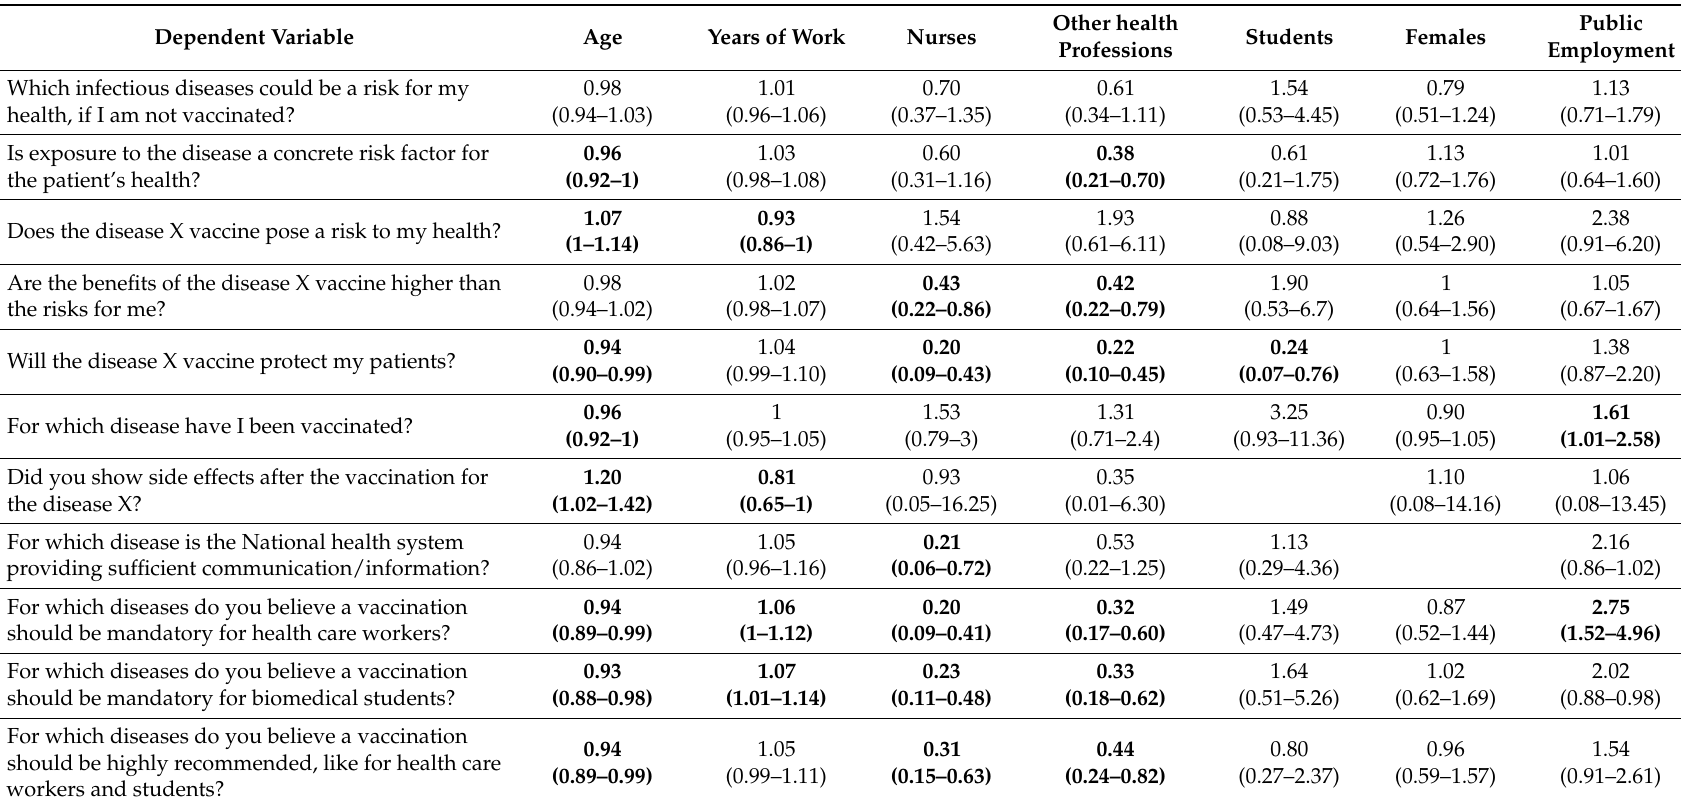
Table 8. Results of the multivariate analysis considering